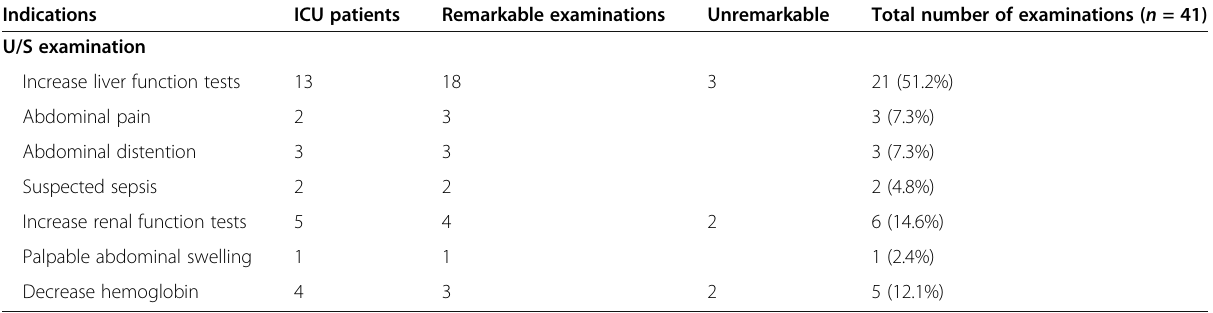
Table 2 Distribution of the imaging studies done for the patients sample according to the indications for the imaging studies (NB: 11 follow-up sonographic studies were done for 8 patients)